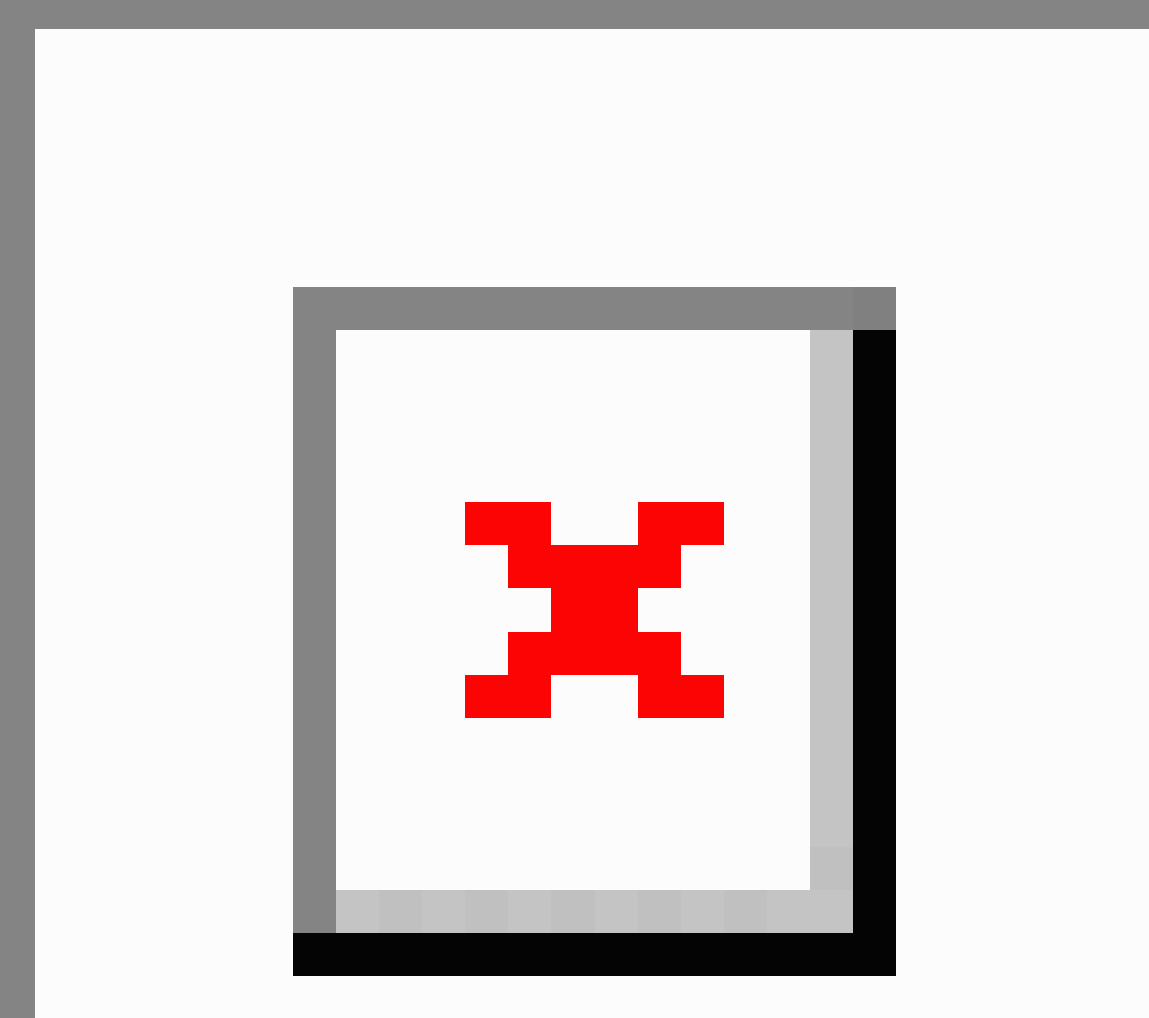
Figure 2. Main screen of mobile Health4U, and five key components of Health Notes: amount of exercise, weight and height, blood pressure with measurement time, blood sugar with measurement time, and laboratory results relevant to users’current medical